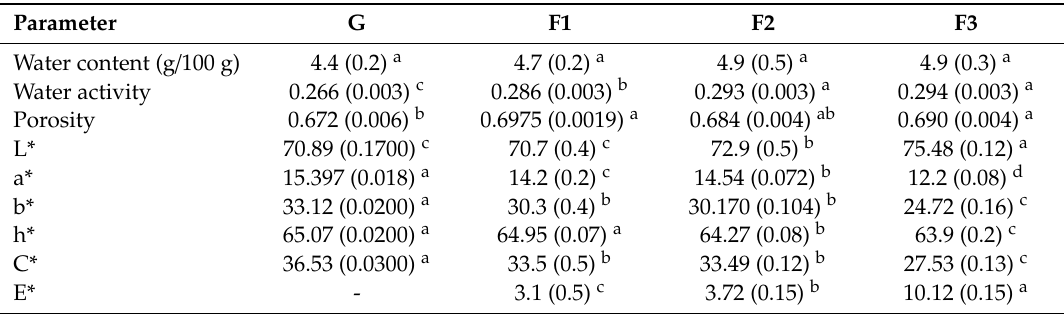
Table 4. Mean values (and standard deviation) of color coordinates (L*, a*, b*), hue angle (h*), chrome (C*), color di ff erences ( ∆ E*), porosity, water content, and water activity of grapefruit powder (G) and each grapefruit formulations (F1, F2, and F3).